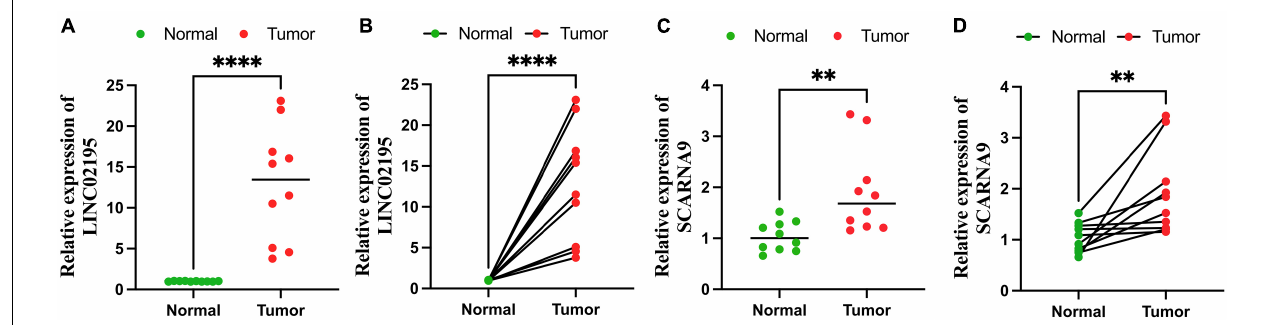
Supplementary Table 1 | Clinicopathologic characteristics of TCGA colon cancer patients. Supplementary Table 2 | List of 90 DEirlncRNAs.